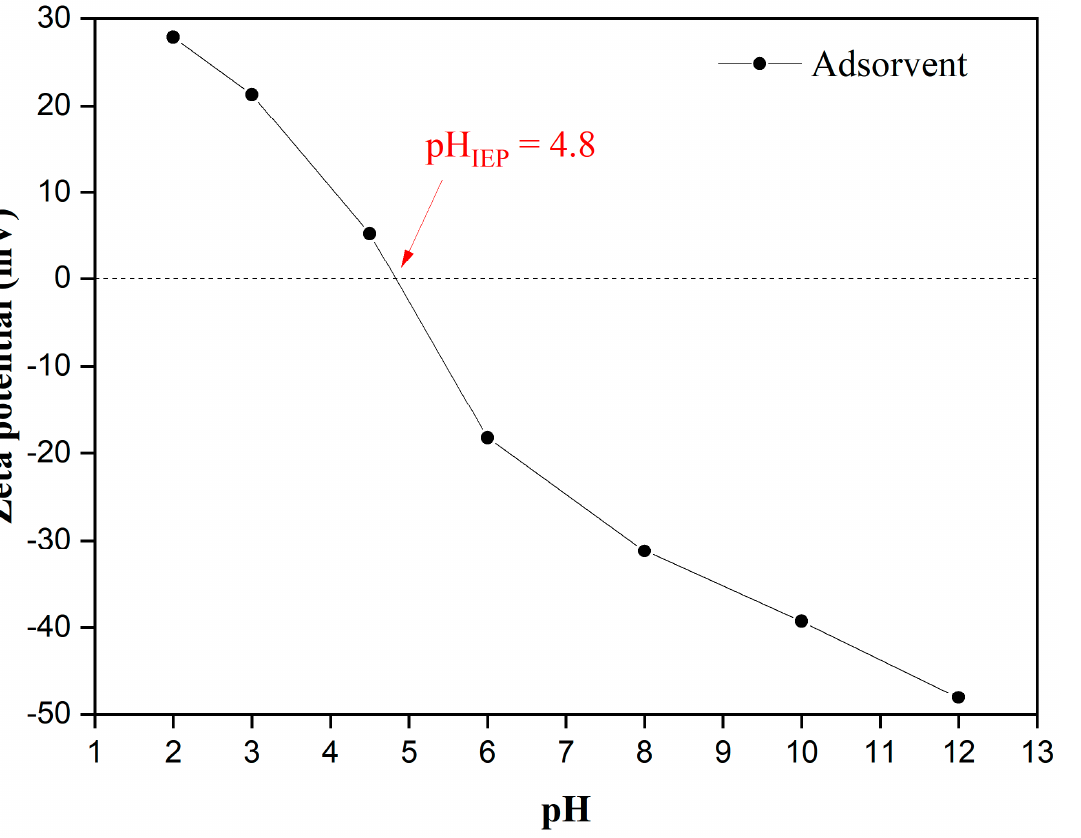
Figure 5. Zeta potential of the low-cost adsorbent synthesized from Moringa oleifera Lam. seeds.